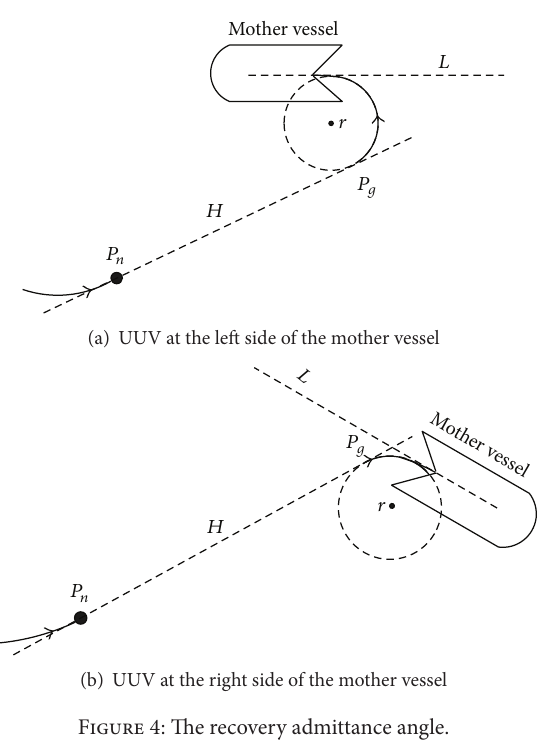
Figure 4: The recovery admittance